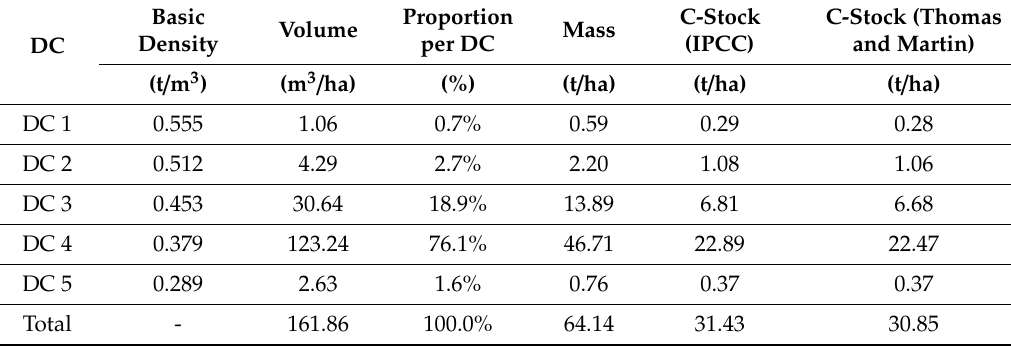
Table 8. Average values for the main parameters of deadwood and carbon estimated distribution per decay classes (DC) in the deciduous oak